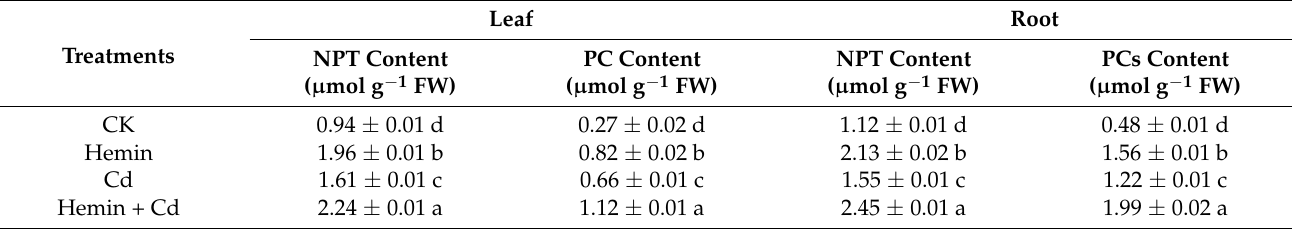
Table 5. Effects of hemin on nonprotein thiol (NPT) and phytochelatin (PC) contents of leaf and root under Cd stress.